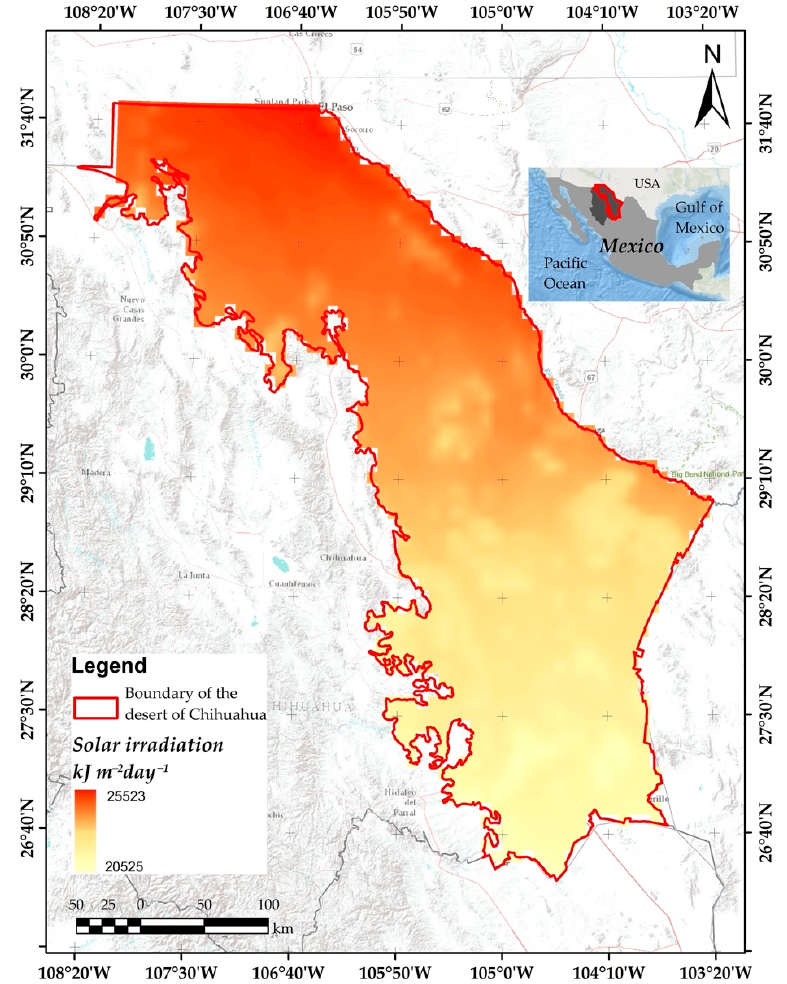
Figure 1. Location of the study area.